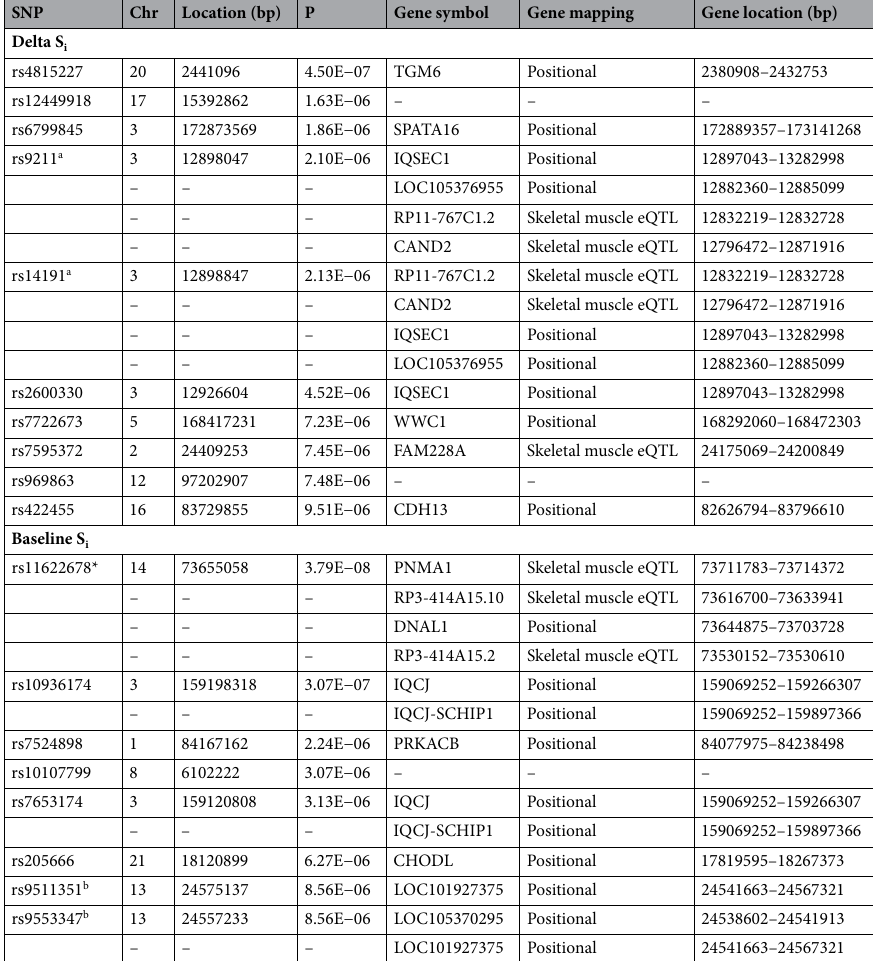
Table 1. Genomic loci showing, at a minimum, suggestive association with ΔS i and baseline S i . *Statistically significant association. a,b r 2 >